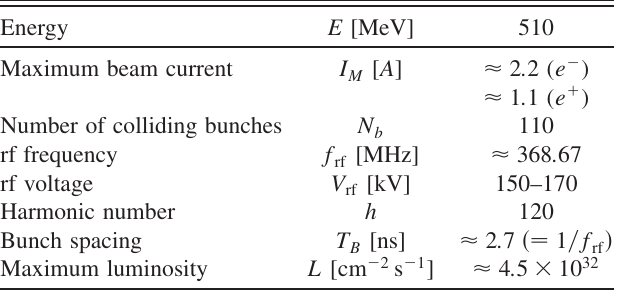
TABLE I. DA(cid:1)NE parameters (SIDDHARTA runs 2008–